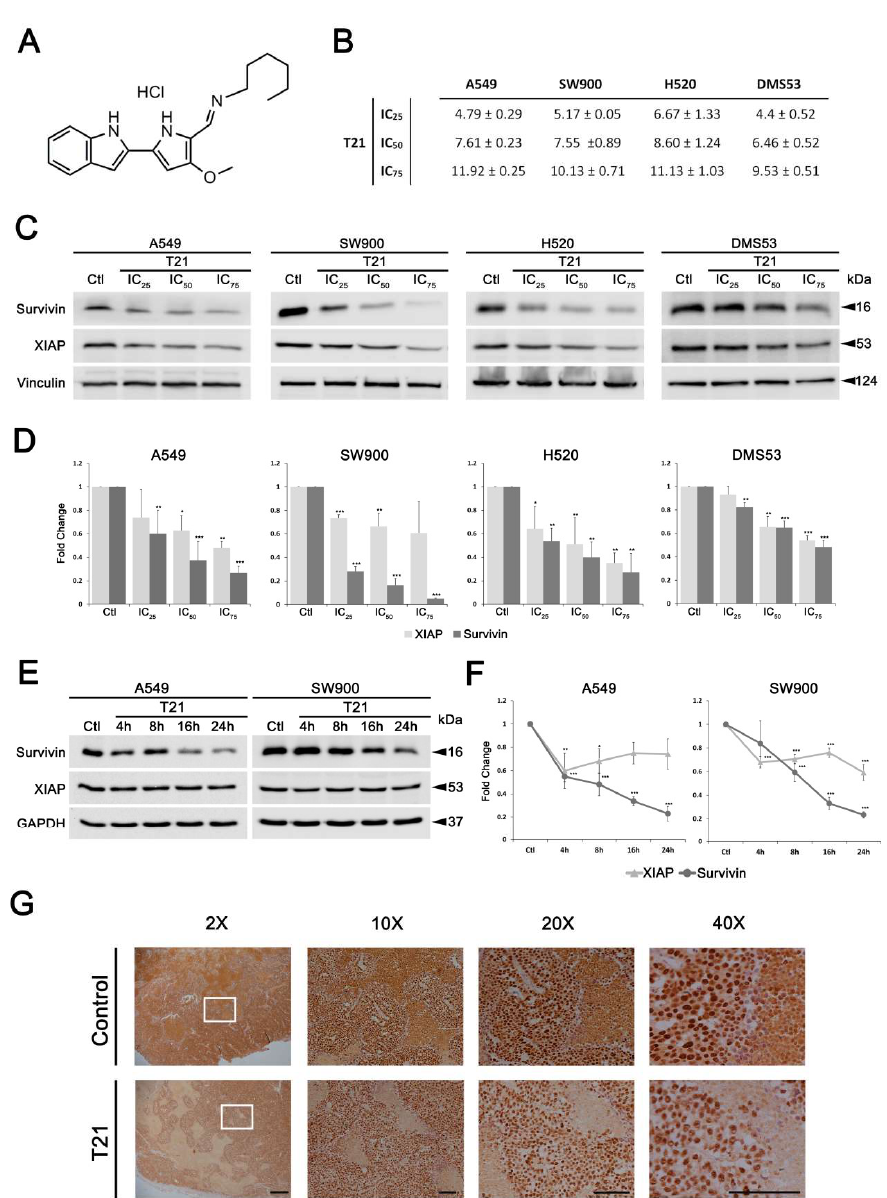
Figure 2. T21 decreases survivin levels in vitro and in vivo. ( A ) T21 chemical structure. ( B ) T21 inhibitory concentration (IC) values calculated in cell viability assays performed in several lung cancer cell lines. Some IC 50 values were previously published in Manuel-Manresa et al. [6]. Values represent mean ± SD in µ M. ( C , D ) After 24 h of treatment with IC 25 , IC 50 , IC 75 values of T21 (Table S1), the expression of survivin and XIAP was analyzed by Western blot analysis in A549, SW900, H520 and DMS53 cell lines. ( E , F ) A549 and SW900 cells were treated with T21 at IC 50 during di ff erent time periods (4, 8, 16, 24 h) followed by survivin and XIAP expression analysis through Western blot analysis. Results were obtained from at least three independent experiments. Bars represent the mean ± SD. Statistically significant results are indicated as *, p -value < 0.05; **, p -value < 0.01 and ***, p -value < 0.001. ( G ) Subcutaneous tumors from implanted DMS53 cells in Crl:NU-Foxn1nu mice were treated with 6 mg / kg of T21 every other day for 20 days. Tumor samples were stained against survivin by immunohistochemistry. Representative illustrations are shown at 2 × , 10 × , 20 × and 40 × magnifications, the scale bars correspond to 500, 500, 100 and 100 µ m,